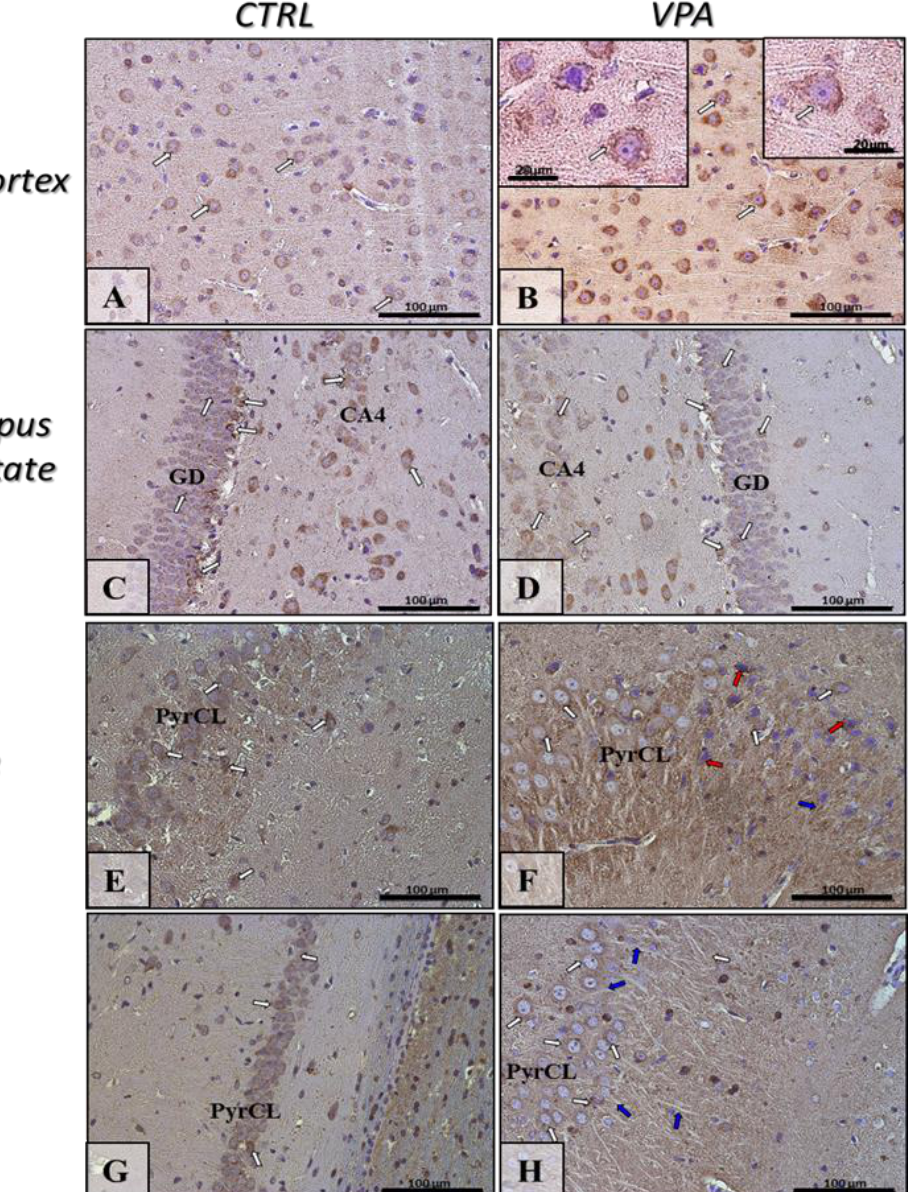
Figure 6. The effect of prenatal exposure to VPA on the immunoreactivity of Tau phosphorylated at (Ser396) in the rat brain. Representative microphotography showing immunoexpression of pTau(Ser396) in the cerebral cortex and hippocampus proper (GD—Gyrus Dentate, CA1-CA4—the regions of Cornu Ammonis) of control rats ( A , C , E , G ) and VPA-treated rats ( B , D , F , H ). IHC reaction. Scale bar: 100 µ m and 20 µ m in insertion of B (objective magnification × 40, × 100, respectively). pTau(Ser396)-immunopositive perikaryons (white arrows); blue arrows—the pTau(Ser396)-immunonegative nerve cells processes; red arrows—pTau(Ser396)-immunonegative neurons with pathologic phenotype (chromatolysis—collapsed cell nucleus as a result of negatively affected cytoskeletal network because of degradation of Nissl bodies and disturbances of cell metabolism); PyrCL—Pyramidal Cell Layer of CA1-CA3 regions. Representative pictures from n = 11 (CTRL) and n = 9 (VPA) independent experiments in both the hippocampus and cerebral cortex are presented.